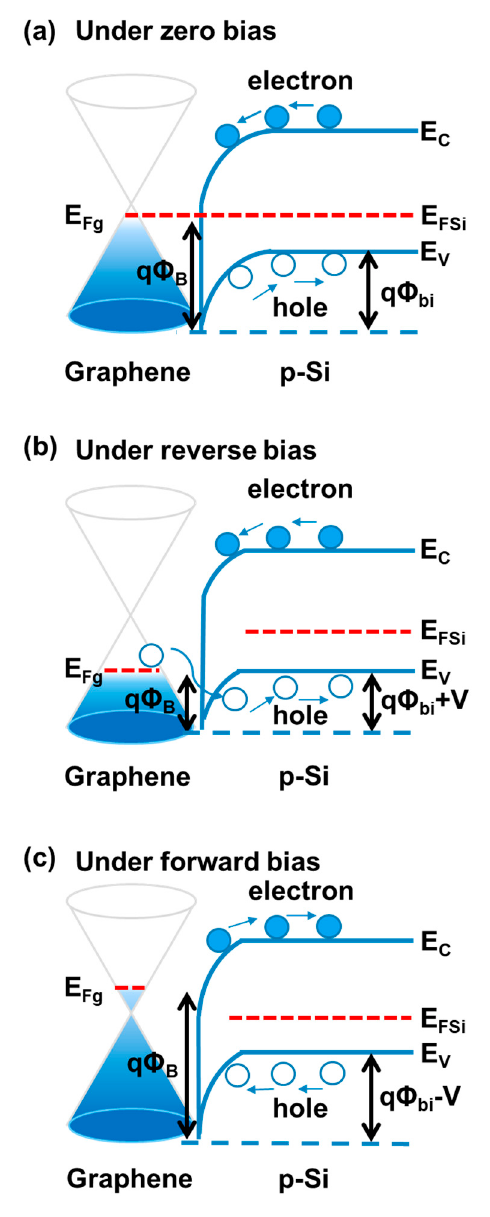
Figure 6. Band diagram of the camphor-based CVD bilayer graphene/p-Si PDs, where E Fg , E FSi , q Φ B (~0.81 eV), and q Φ bi (~0.62 eV) are the Fermi energy of graphene, the Fermi energy of Si, the Schottky barrier height (SBH), and the hole barrier height, respectively. ( a ) Under zero bias, ( b ) under reverse bias, and ( c ) under forward bias. Charge carriers (holes) are shown as open circles.